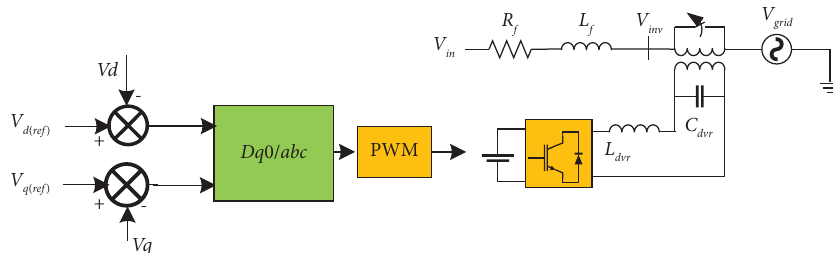
Figure 10: Te connection of DVR to the PCC with its control system.